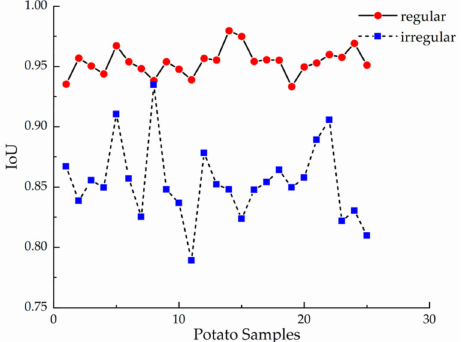
Figure 13. IoU values for regular and irregular potatoes.